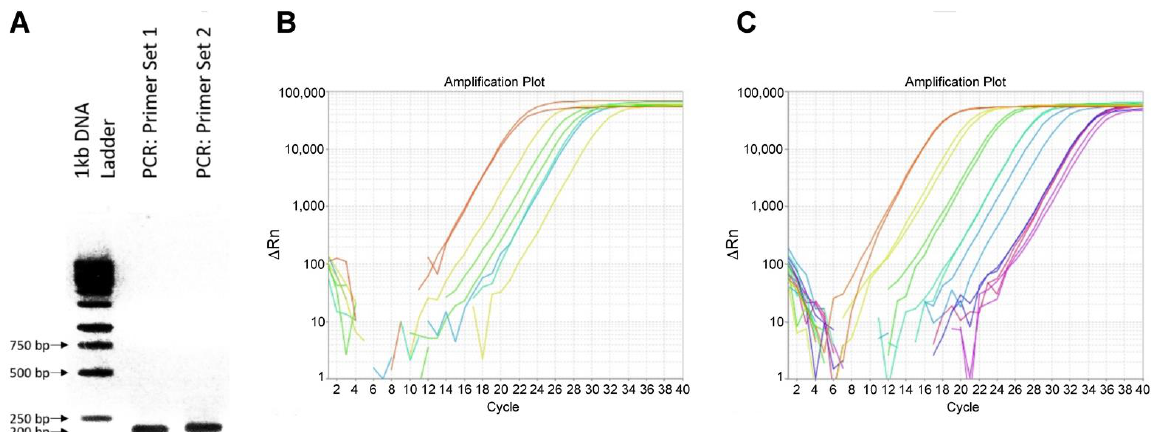
Figure 2. Production of viral particles. ( A ) PCR products post-amplification run on a 2% agarose gel. Both primer sets returned the expected 200 bp product. ( B ) qPCR sample results. Red: 1× sample, Yellow: 0.1× sample, Green: 0.01× sample, Blue: 0.001× sample. ( C ) qPCR standard curve. Red: 5 × 10 7 copies, Yellow: 5 × 10 6 copies, Green: 5 × 10 5 copies, Teal: 5 × 10 4 copies, Blue: 5 × 10 3 copies: Dark Blue/Purple: negative control.